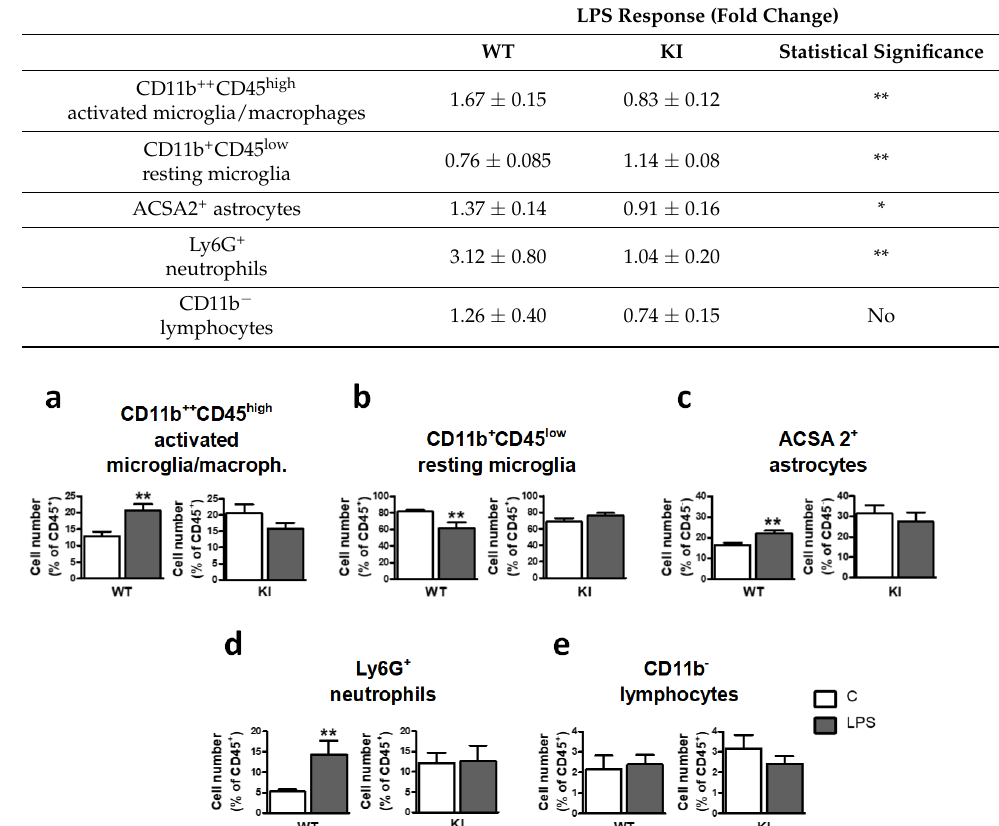
Figure 3. Neuroimmune cells from GSK3 β Ser 389 KI mice fail to respond to LPS. Adult WT and GSK3 β Ser 389 KI mice were injected intraperitoneally with LPS (0.5 mg/kg). Three days later, brain populations of ( a ) CD11b ++ CD45 high activated microglia/macrophages, ( b ) CD11b + CD45 low resting microglia, ( c ) ACSA-2 + astrocytes, ( d ) Ly6G + neutrophils, and ( e ) CD11b − lymphocytes were evaluated by flow cytometry. Histograms show LPS effects on cell number in both genotypes. Data are presented as percentages of CD45 − cells (astrocytes) or CD45 + cells (all other populations), and values correspond to mean ± S.E.M ( n = 7–9). Student t -test was applied to evaluate the significance of changes induced by LPS in each genotype. ** p < 0.01. WT, wild-type; KI, GSK3 β Ser 389 knockin; LPS, lipopolysaccharide. Table 1. Differences in LPS effects between WT and GSK3β Ser 389 KI mice. Values represent cell number after LPS treatment in each genotype and are expressed as an increase with respect to vehi- cle-treated controls (mean ± S.E.M). Asterisks indicate statistically significant differences between the effects of LPS in WT and GSK3β Ser 389 KI animals. WT, wild- type; KI, GSK3β Ser 389 knockin; LPS, lipopolysaccharide. *, p < 0.05; **, p < 0.01.